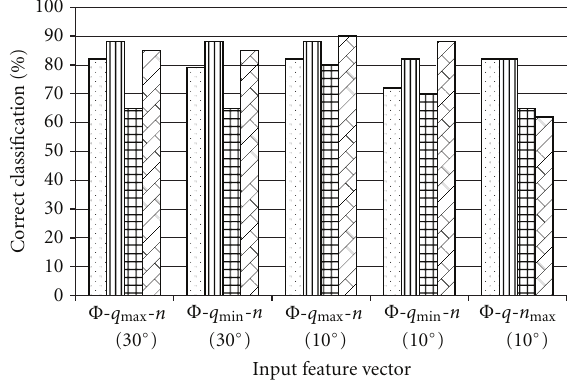
Figure 16: Classification capability of OPNN and APNN with five types of feature inputs with 4- and 5-types of overlapped patterns— without clustering algorithm (in the histogram dotted chequered blocks refer to 4 and 5 type inputs to PNN; striped and brick blocks refer to 4- and 5-type inputs to